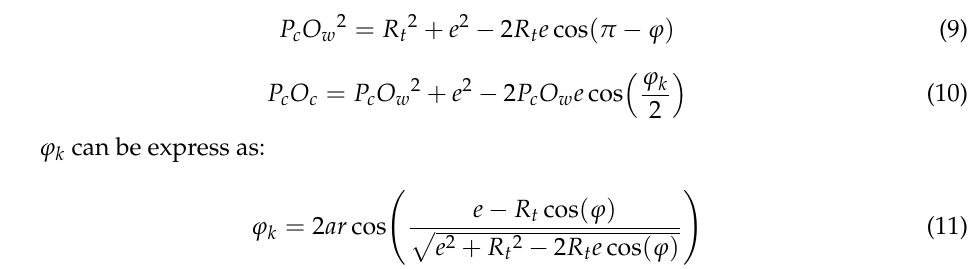
Figure 4. The natural frequency simulation values of the PKM at position 7.